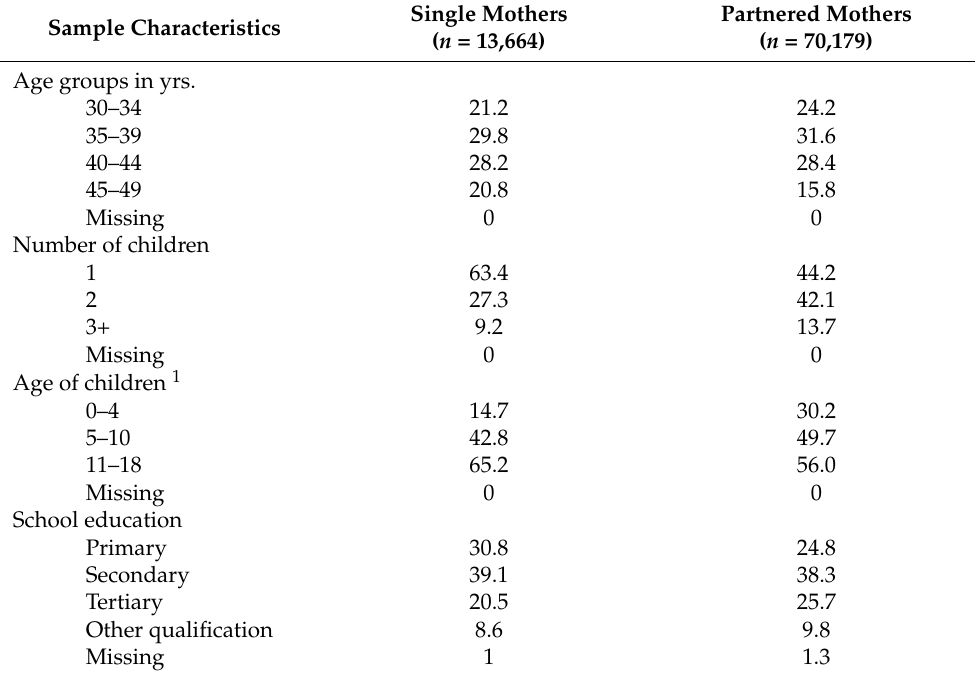
Table 2. Weighted sample characteristics of single and partnered mothers aged 30–49 years in Germany between 1994 and 2018 (in %). Sample